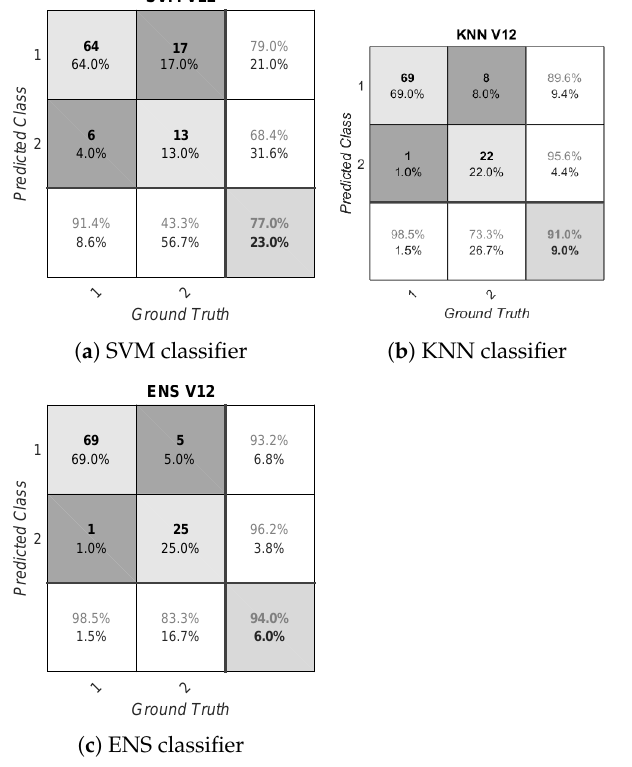
Figure A10. Confusion matrices for a subject-dependent model for